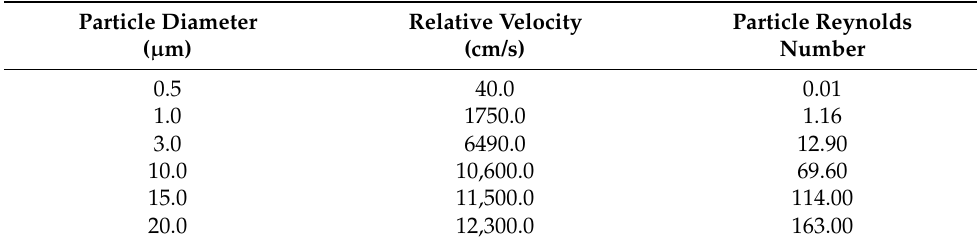
Table 2. Particle properties in